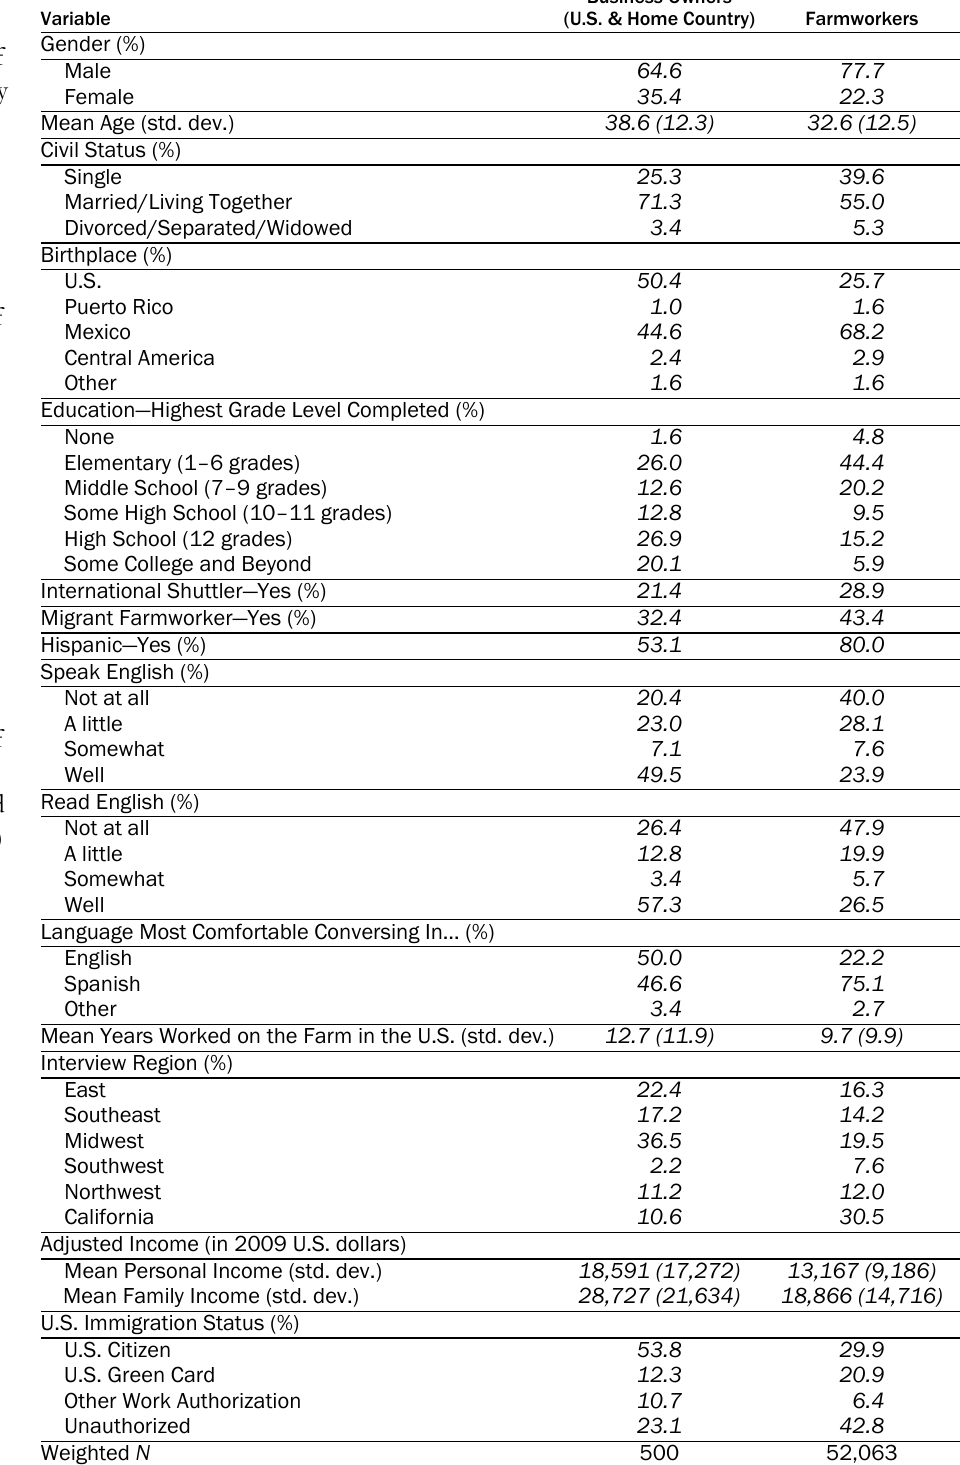
Table 1. U.S. Farmworker Descriptive Statistics at Time of Survey